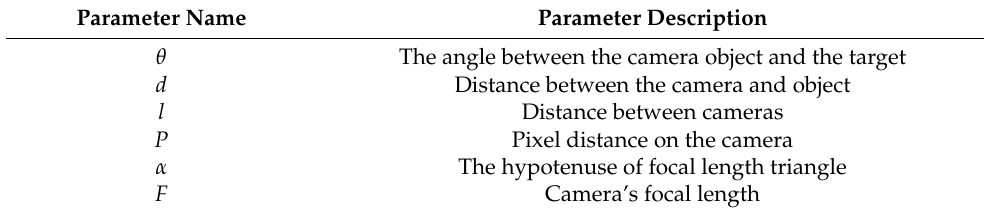
Figure 3. Distance angle between the marker and camera’s center point. Table 1. Definition of parameters in the stereo